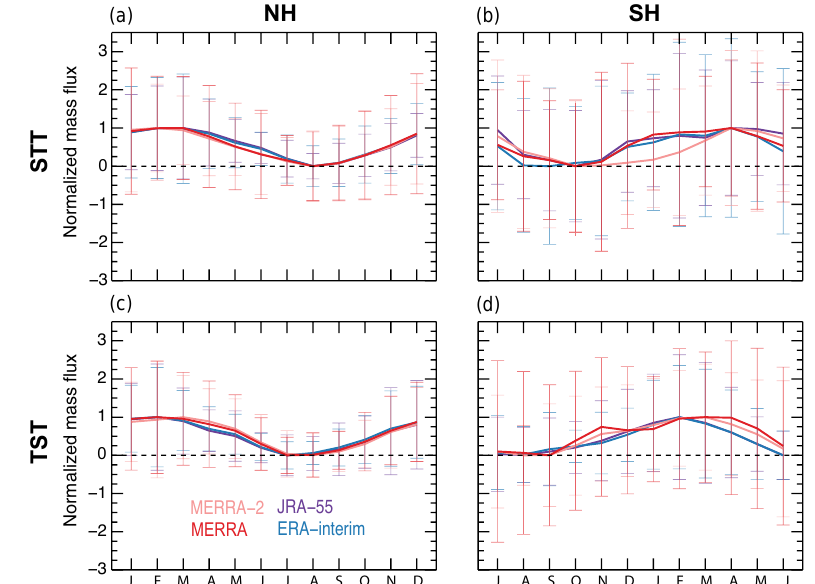
Figure 9. Annual cycles of (top row) normalized STT and (bottom row) normalized TST for the (left) extratropical Northern Hemisphere and (right) extratropical Southern Hemisphere from each reanalysis model. In each plot, the solid colored lines are the mean annual cycles and the colored error bars are plus/minus 1 standard deviation from the mean. STE from JRA-55 is shown by the purple lines, ERA-Interim by the blue lines, MERRA-2 by the light red lines, and MERRA by the dark red lines. Note that NH and SH annual cycles are offset by 6 months.